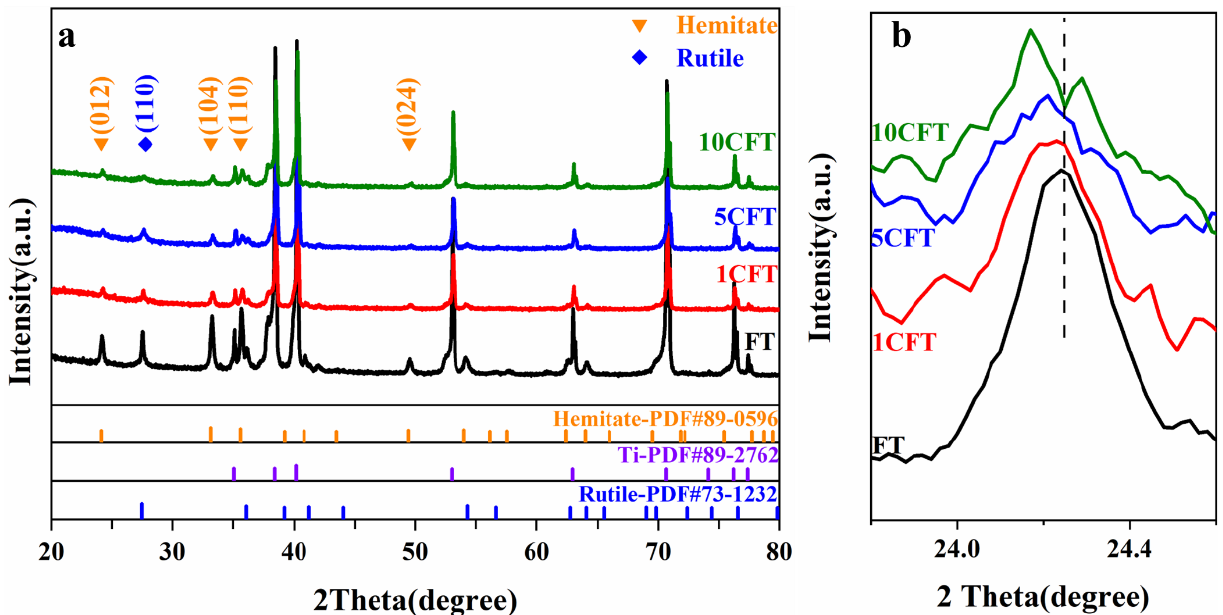
Figure 1. ( a ) XRD patterns of Fe 2 O 3 (FT) and Ce-doped Fe 2 O 3 (1CFT, 5CFT, 10CFT); ( b ) 23.5 – 25.0° Refined spectrum of ( a ).